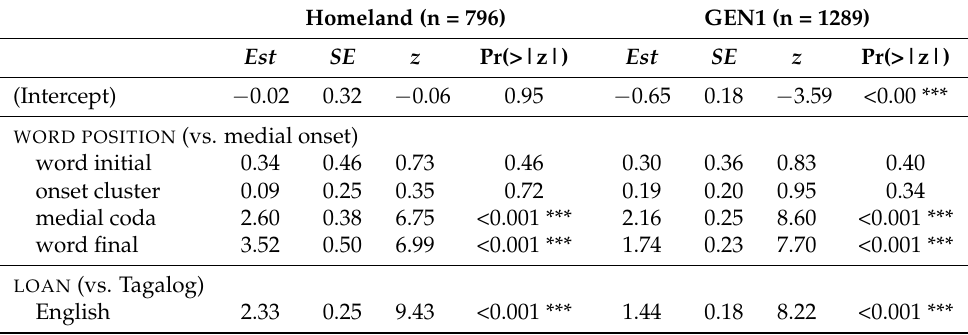
Table A1. Post-hoc analysis for HOM vs. GEN1 comparison, evaluating the effect of WORD POSITION and LOAN for Homeland and GEN1 speakers separately. Significance code: <0.001 ‘***’.